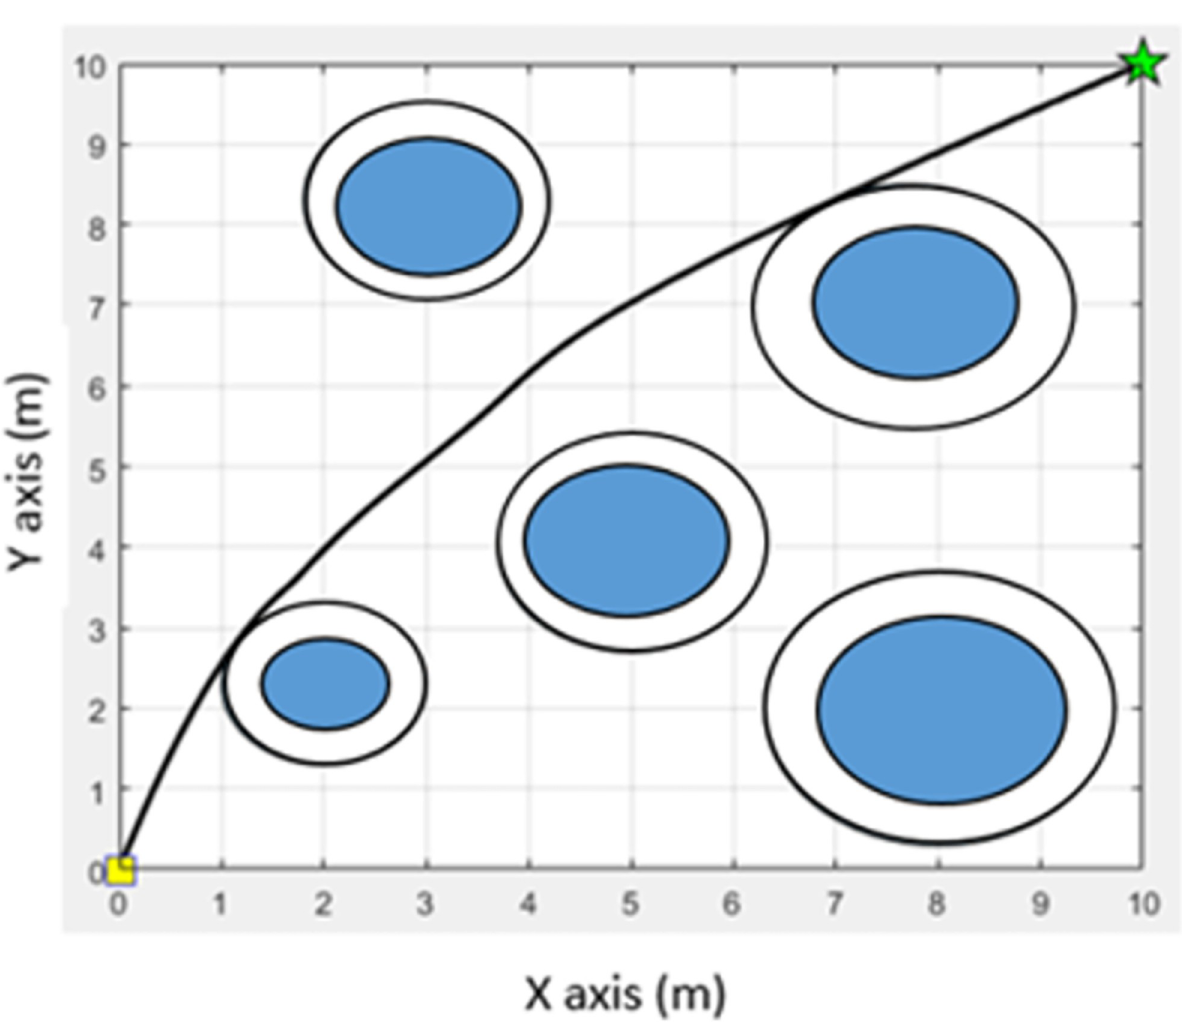
Fig 21. The path obtained from the MOEPSO algorithm in a static environment (5